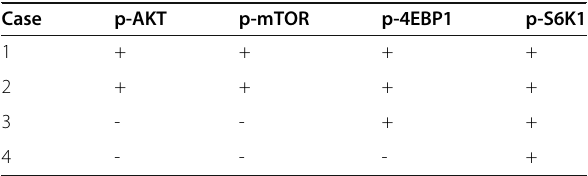
Table 3 Immunohistochemical expression of mTOR pathway in abnormal